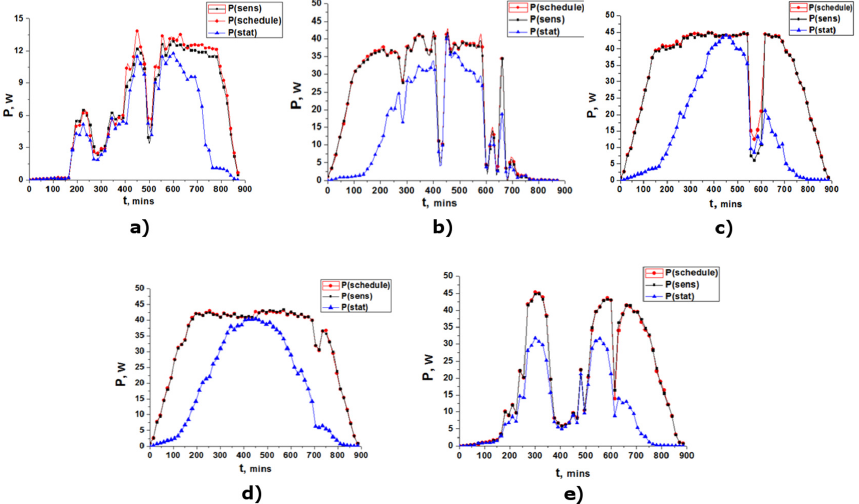
Figure 10. Generation of energy on: ( a ) 1 July 2020, ( b ) 2 July 2020, ( c ) 3 July 2020, ( d ) 8 July 2020, ( e